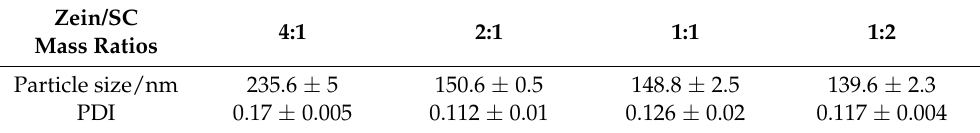
Table 1. Particle size and PDI values of the CA-loaded nanoparticles with different zein/SC mass